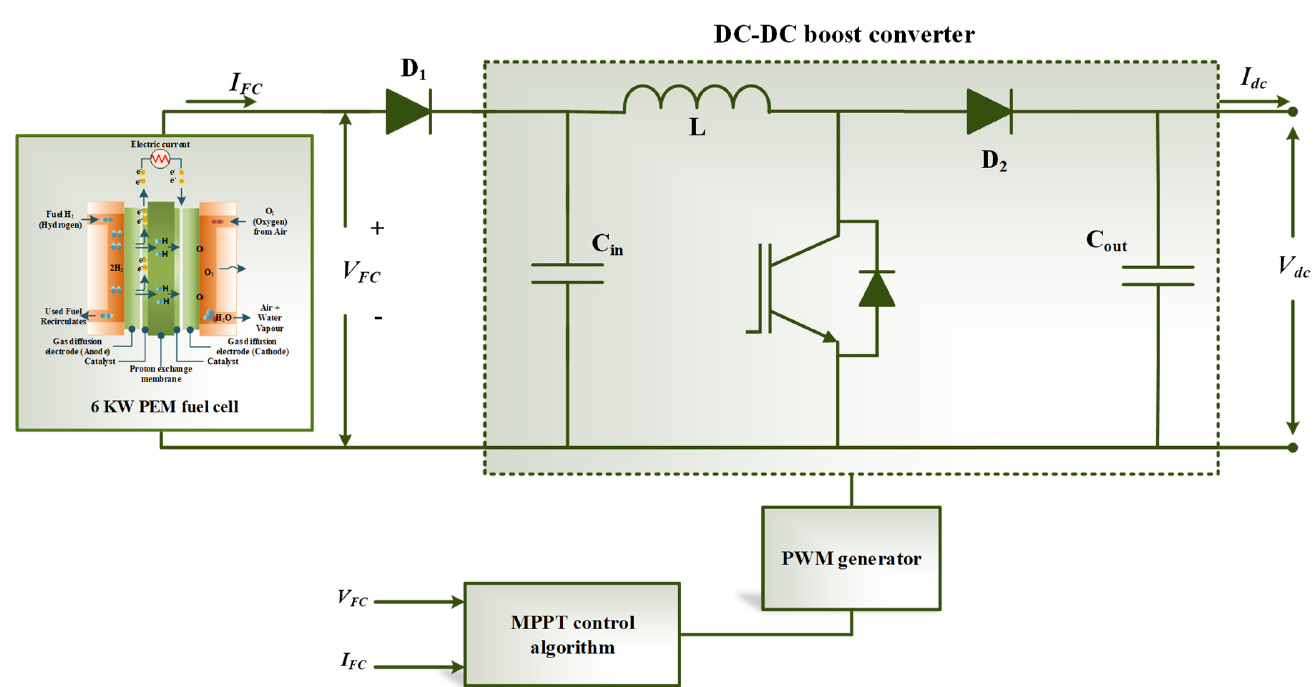
Figure 3. PEMFC and dc-dc boost converter.